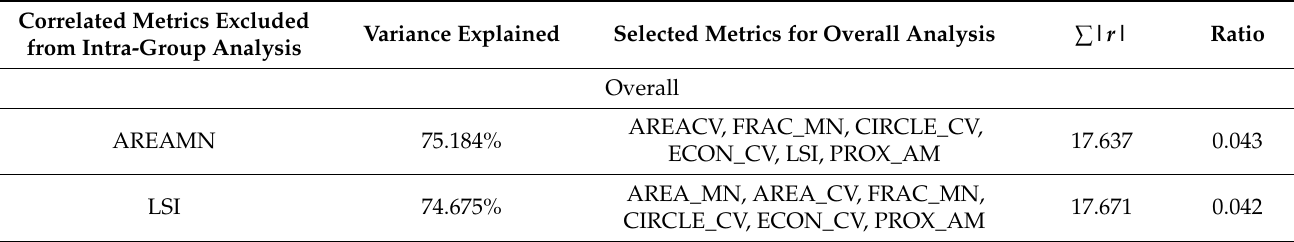
Table 2. Metric selection for Overall analysis where strong correlation